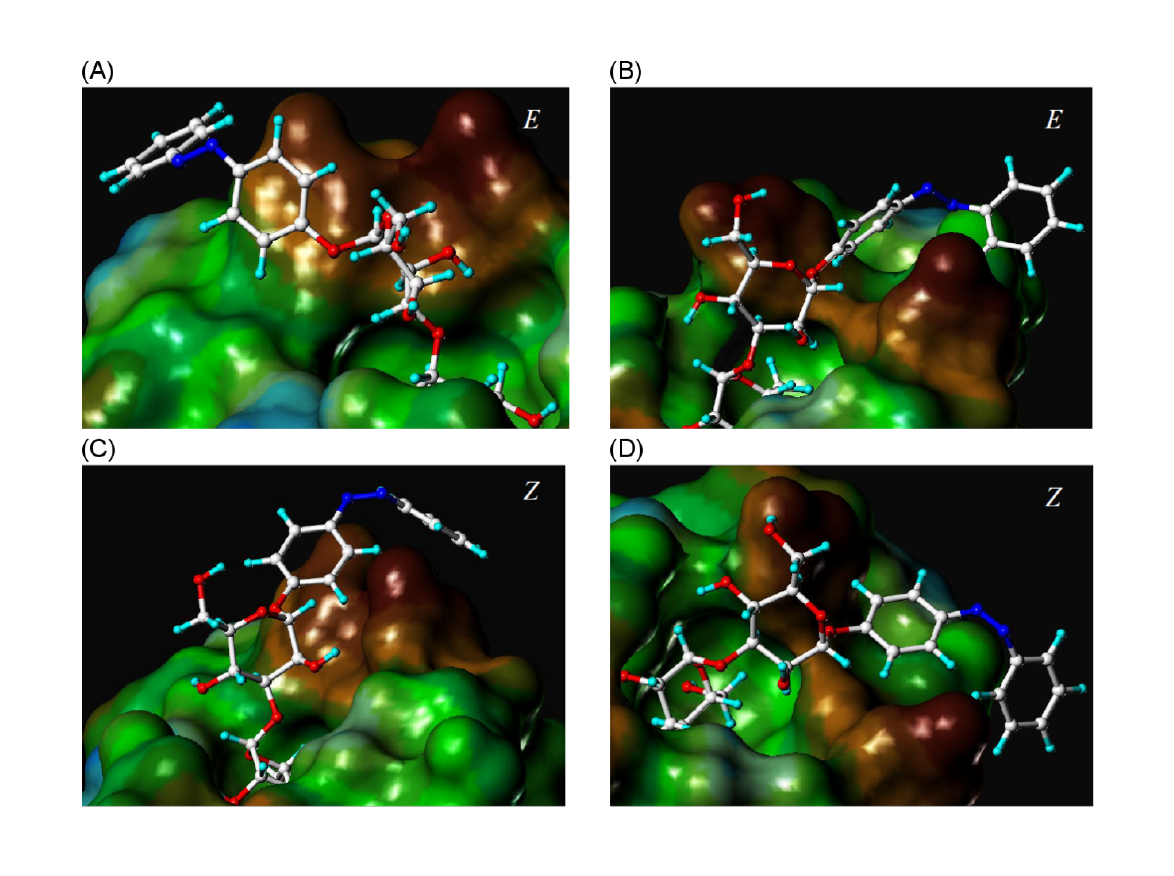
Figure 2: Connolly [32,33] descriptions of the FimH CRD with the docked azobenzene mannobioside 2 . Top: ( E )-isomer (A, closed-gate; B, open-gate conformation). Bottom: ( Z )-isomer (C, closed-gate; D, open-gate